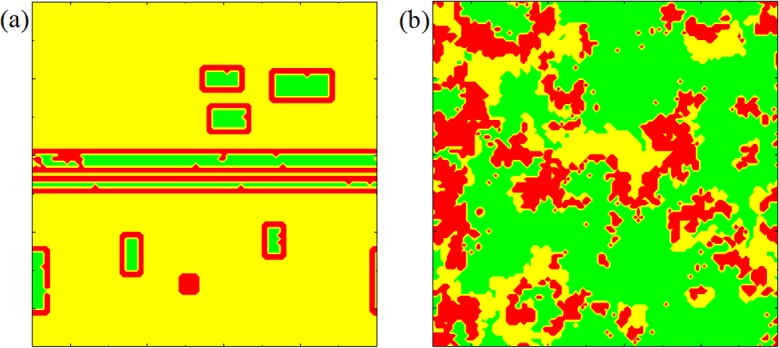
Evolution of cooperation on stable state under some certain initial condition.Panel (a) (or (b)) features the characteristic snapshots of the spatial grid when A = 0.75 (A = 0.751) and b = 1.5, as obtained when using the initial conditions presented in Fig 3(H) (cooperators are yellow, defectors are red and loners are green).